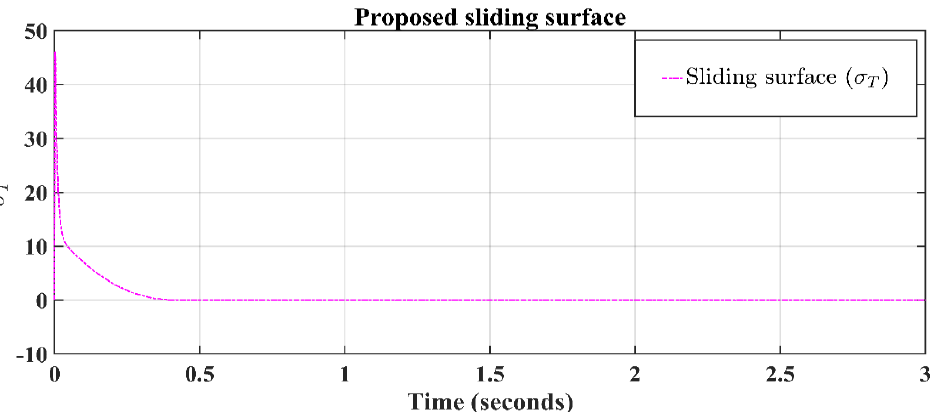
Figure 5. The response of the total backstepping ISMC surface ( 𝜎 (cid:3021) ) for developing proposed control algorithms.